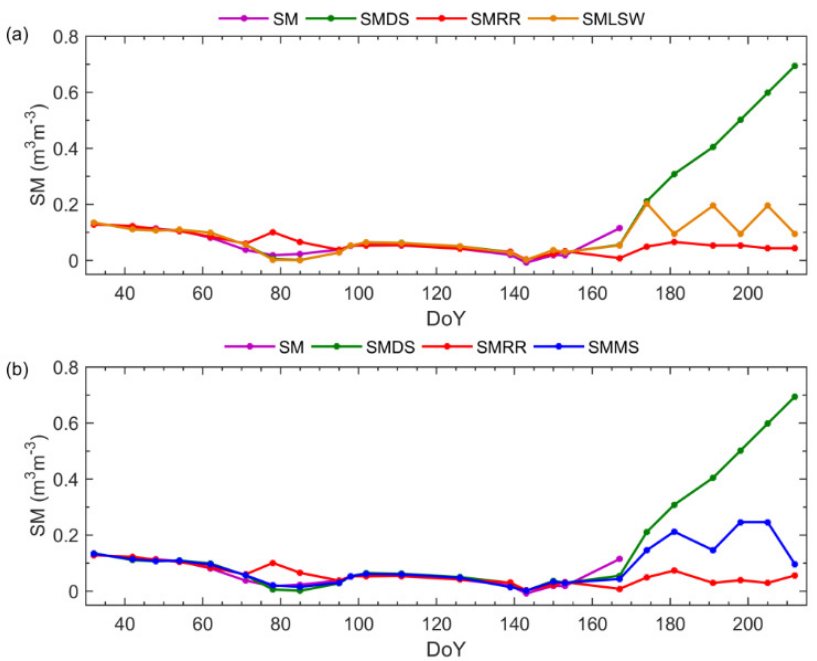
Figure 8. Combination prediction for soil moisture: ( a ) weighted least squares; ( b ) mean squared. SM: interpolated data; SMDS: double smoothing; SMRR: robust regression SMLSW: weighted least squares; SMMS: mean squared.